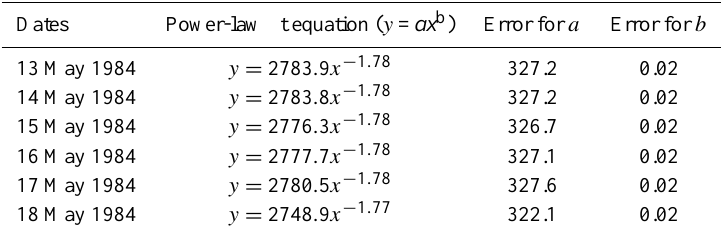
Table 4. Dates and fit equations along with the errors of the coefficients for water albedo shown in Fig. 3. All given a , b values are statistically significant at the 95% confidence interval.